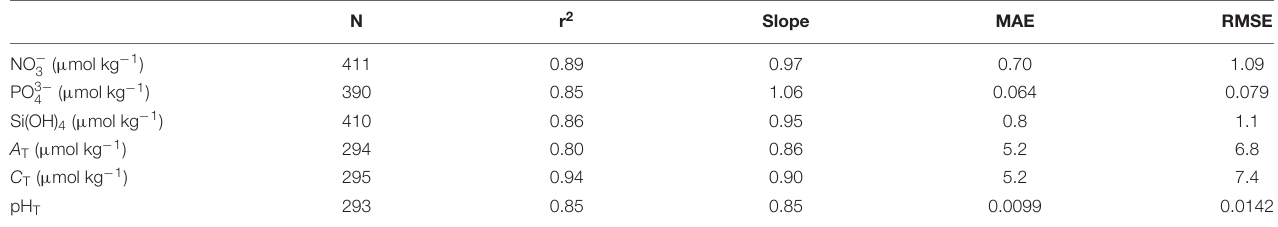
TABLE 3 | Statistics between in situ measurements from the ANTARES time series and the values predicted by CANYON-MED for NO − 3 , PO 3 − 4 , Si(OH) 4 , A T , C T and pH T . N r